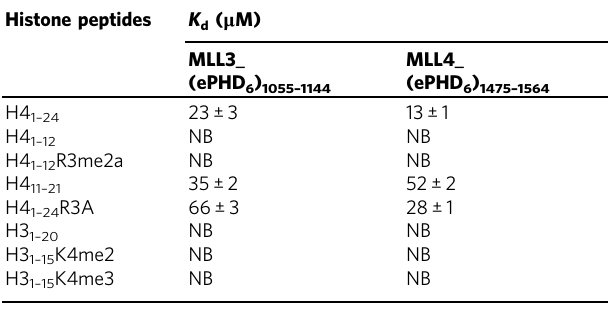
Table 1 Binding af fi nities of different histone peptides to the ePHD 6 of MLL3 and MLL4 measured by ITC Histone